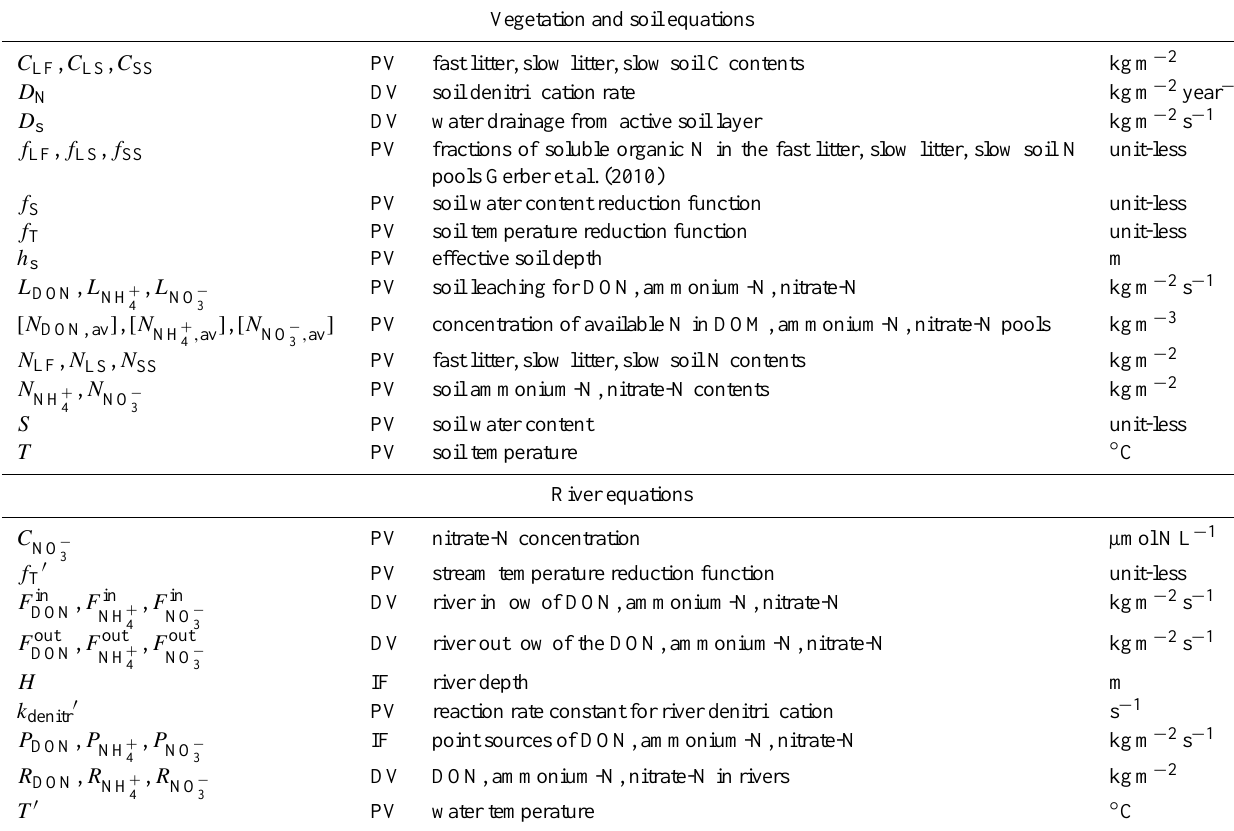
Table 2. Definition of prognostic (PV) and diagnostic (DV) variables and inputs/forcings (IF) used in the equations. Vegetation and soil